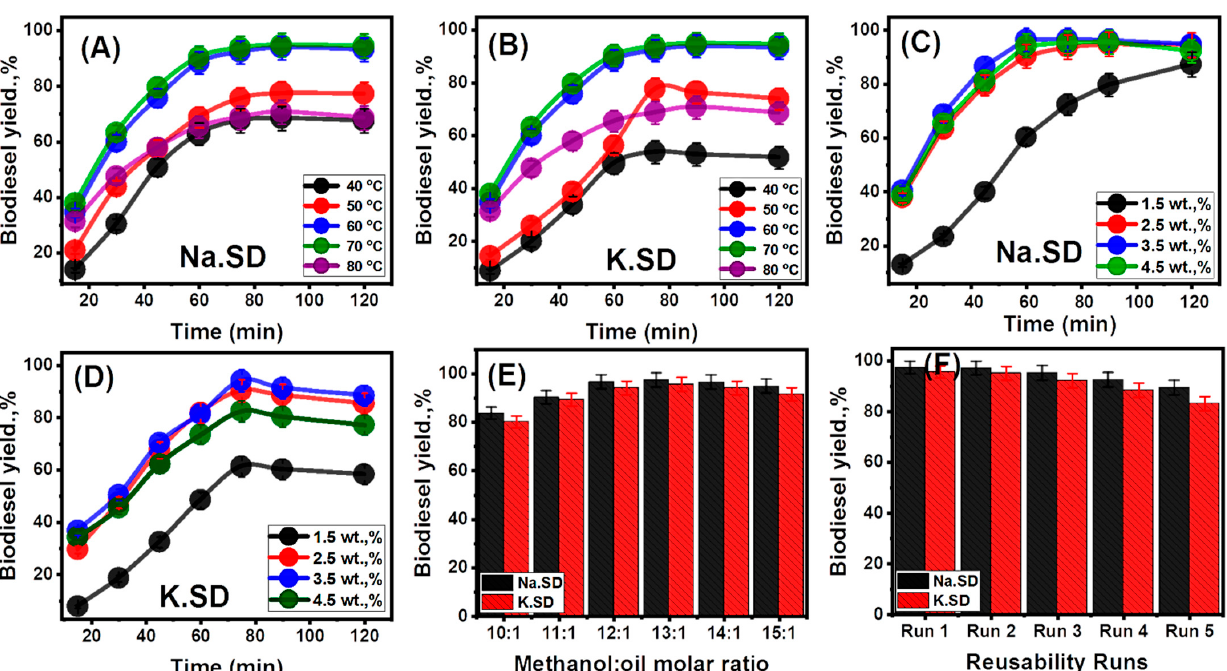
Figure 3. The effect of ( A ) the transesterification duration in different temperature conditions on the catalytic activity of Na.SD, ( B ) the transesterification duration on the catalytic activity of K.SD, ( C ) the effect of the catalyst loading of Na.SD on the obtained biodiesel yield, ( D ) the effect of the catalyst loading of K.SD on the obtained biodiesel yield, ( E ) the methanol-to-oil molar ratio, and ( F ) the recyclability properties of Na.SD and K.SD as heterogeneous catalysts. Effects of the Catalysts Dosages on FAME